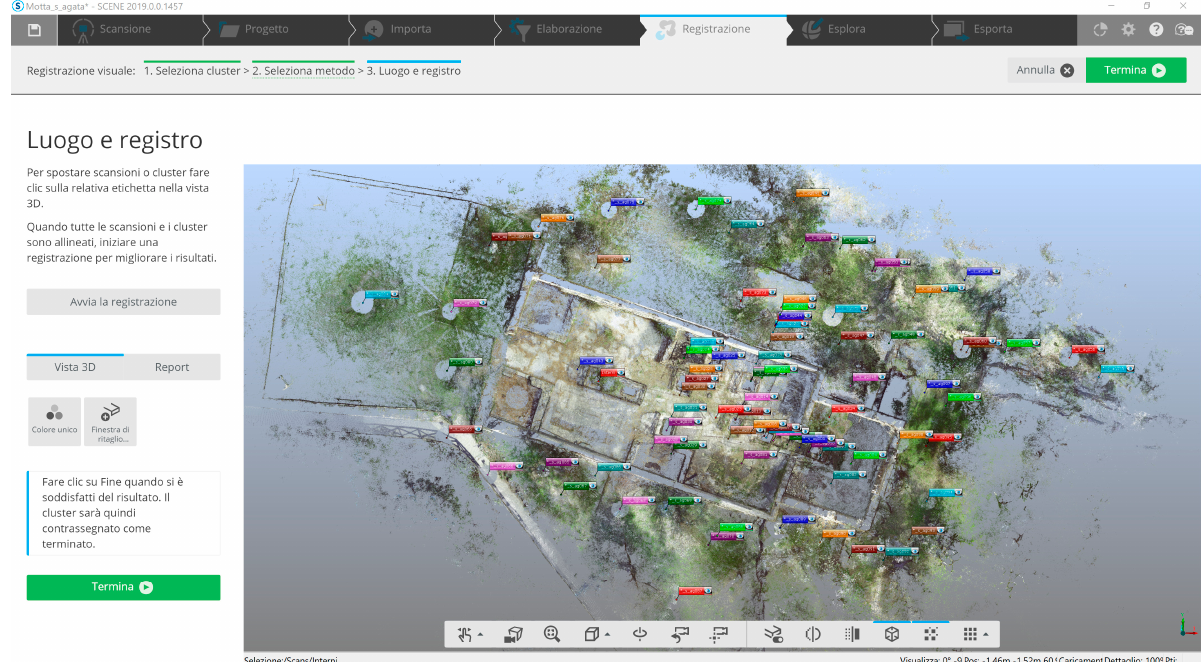
Figure 13. Cloud to cloud global optimization process: e.g., Church of S. Nicola di Motta S. Agata.